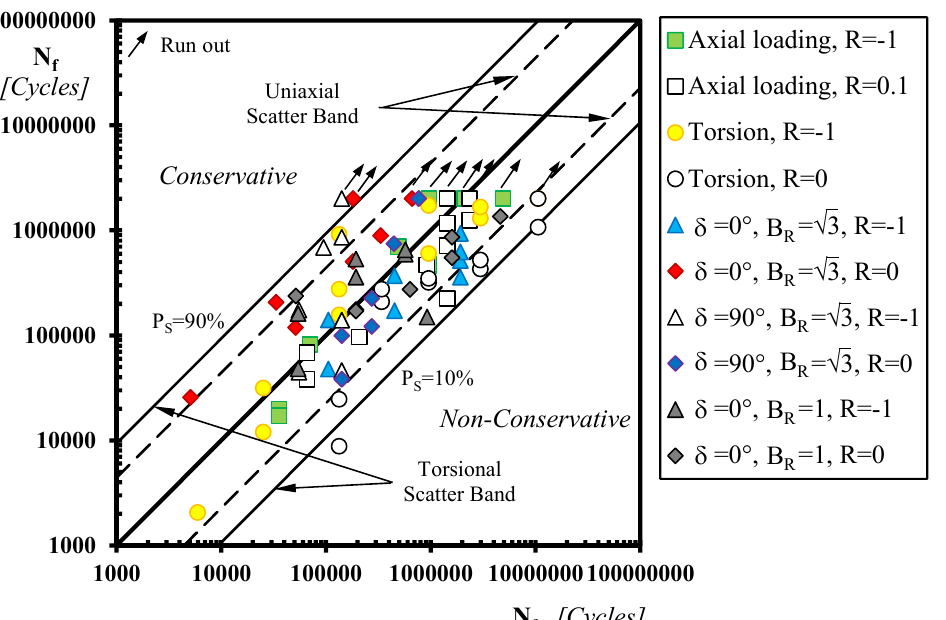
Figure 6: Accuracy of the MWCM in estimating the fatigue lifetime of the tested Al 6082-T6 FS welded joints.